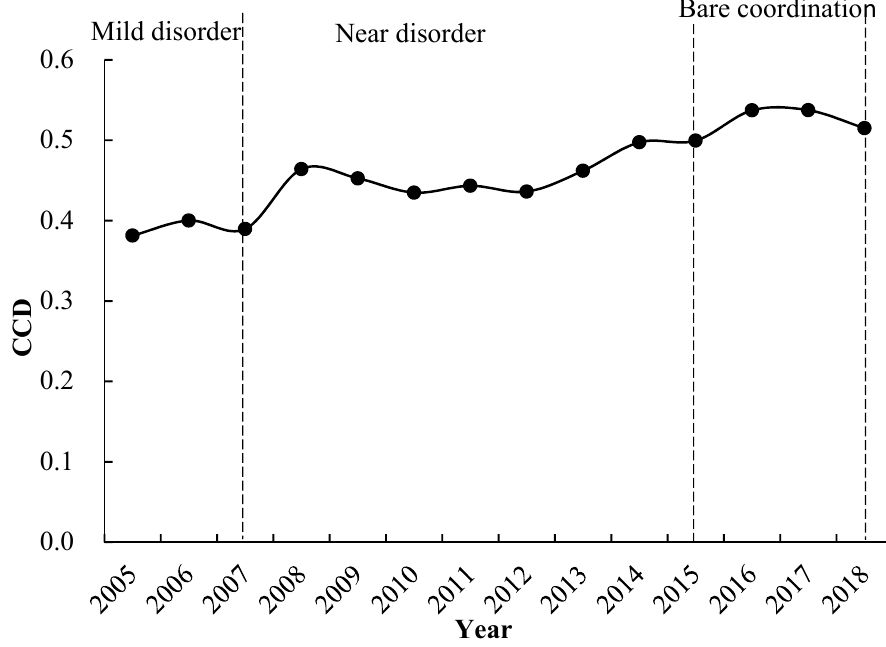
Figure 6. CCD type between the SEBs and EEBs systems of Koktokay Global Geopark.